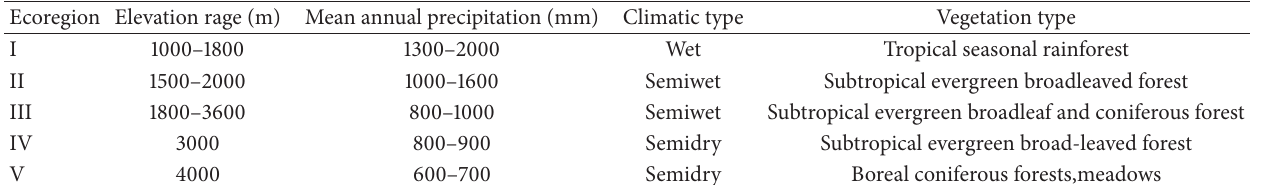
Figure 1: Location of the study area, the dots mark the locations of the observation stations with meteorological data for five ecoregions in Yunnan province. Table 1: Climate, vegetation, and topography for five ecoregions in Yunnan